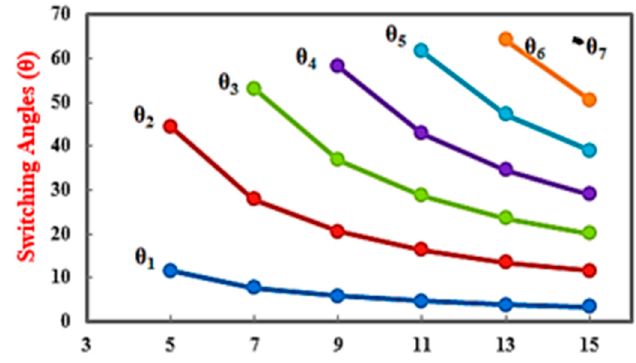
Figure 6. Number of levels vs switching angle.